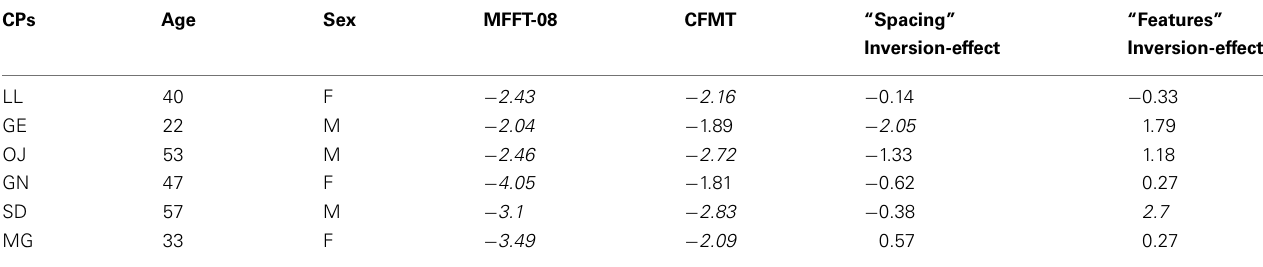
Table 1 | Biographical information for the six CPs, z -scores on the MACCS Famous FaceTask 2008 (MFFT-08), the Cambridge Face MemoryTest (CFMT) adjusted for age (see Bowles et al., 2009 for normative data), and z -scores for the face-inversion effect on the spacing and features sets of the Jane